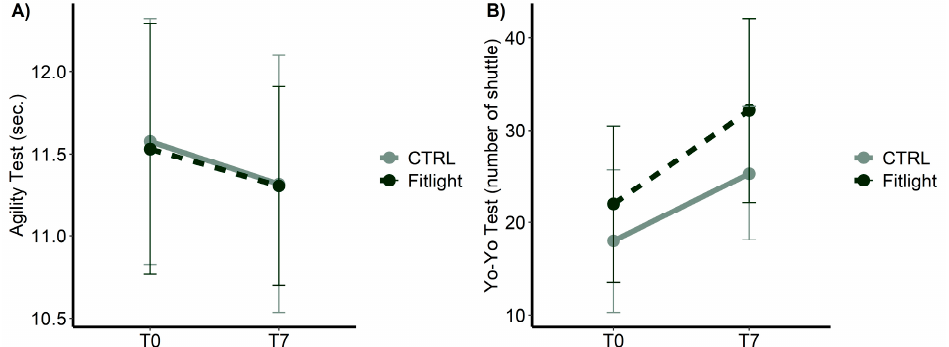
Figure 6. Fitness tests measured over time and between the groups in all conditions. ( A ) Agility test; ( B ) Yo-Yo test.